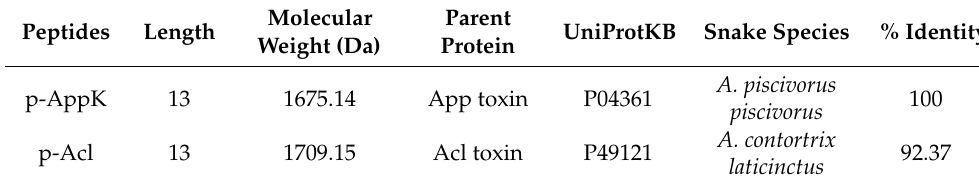
Table 1. The biomimetic peptides were designed to replicate the C-terminal region (residues 115–129) of two membrane-damaging Lys49-PLA 2 from Agkistrodon spp. venoms. The molecular weight was estimated by PepCalc (https://pepcalc.com/, accessed on 1 December 2021), and the sequence identity was calculated by the Sequence Identity and Similarity tool (SIAS, http://imed.med.ucm.es/ Tools/sias.html, accessed on 1 December 2021).